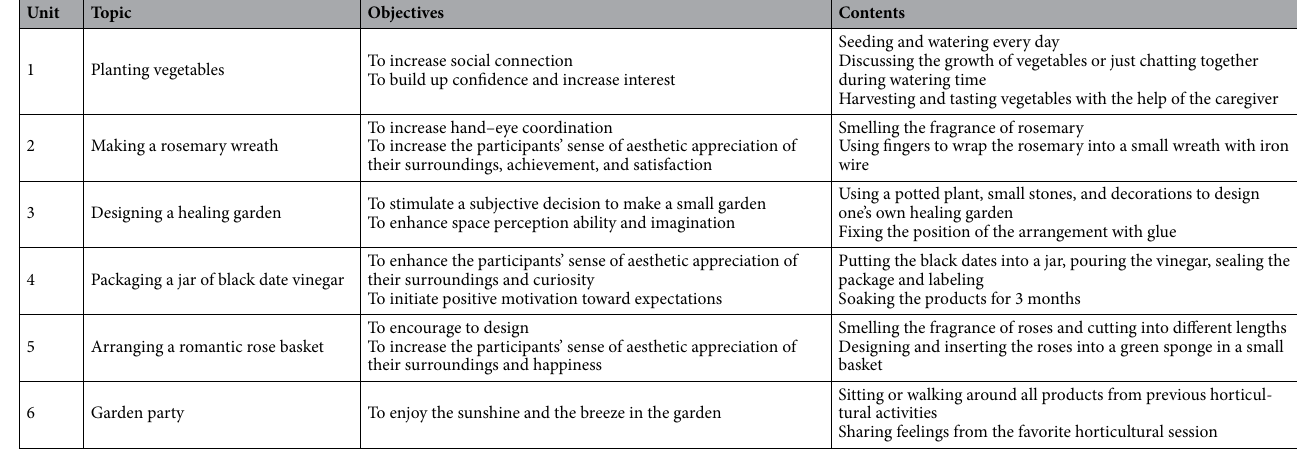
Table 1. The objectives and contents of the six horticultural activity